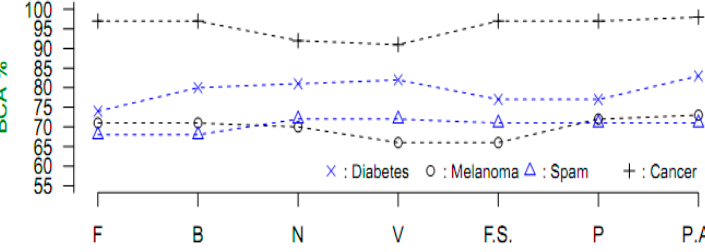
Figure 2. BCA results of the ranking algorithms, where F: Forward selection; B: Backward elimination; N: Nvmax; V: varlmp; F.S.: Fisher score; P: Pearson’s correlation; P.A.: Proposed Algorithm.